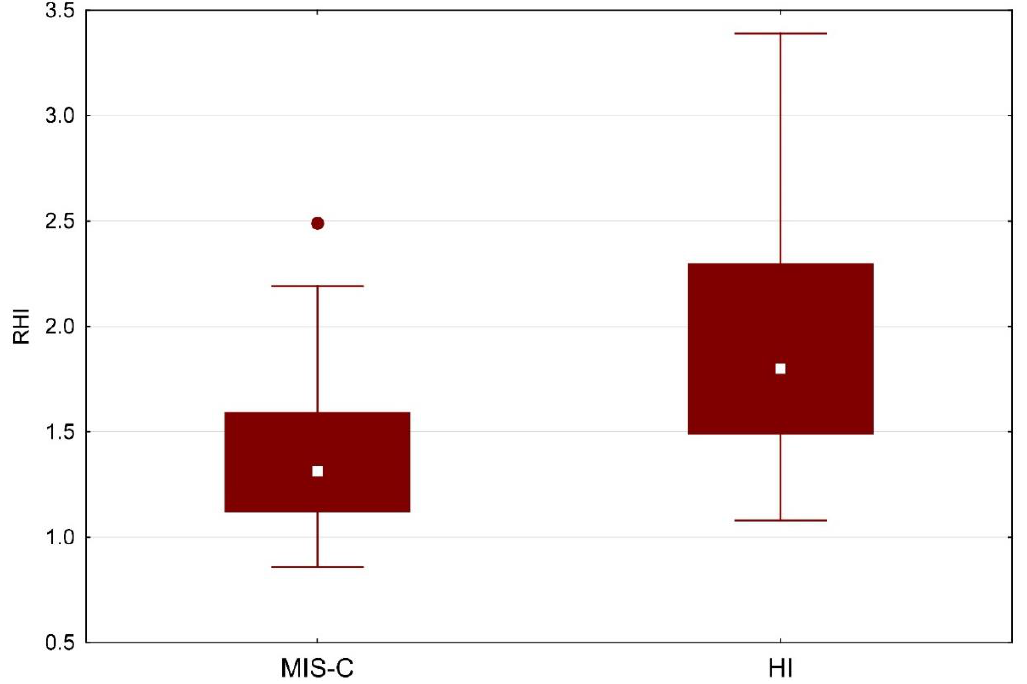
Figure 1. RHI in MIS-C vs. HI. Boxes indicate the interquartile range. White squares within boxes indicate medians. Whiskers extend to the highest or lowest values. HI: healthy individuals; MIS-C: multisystem inflammatory syndrome in children; RHI: reactive hyperemic index.